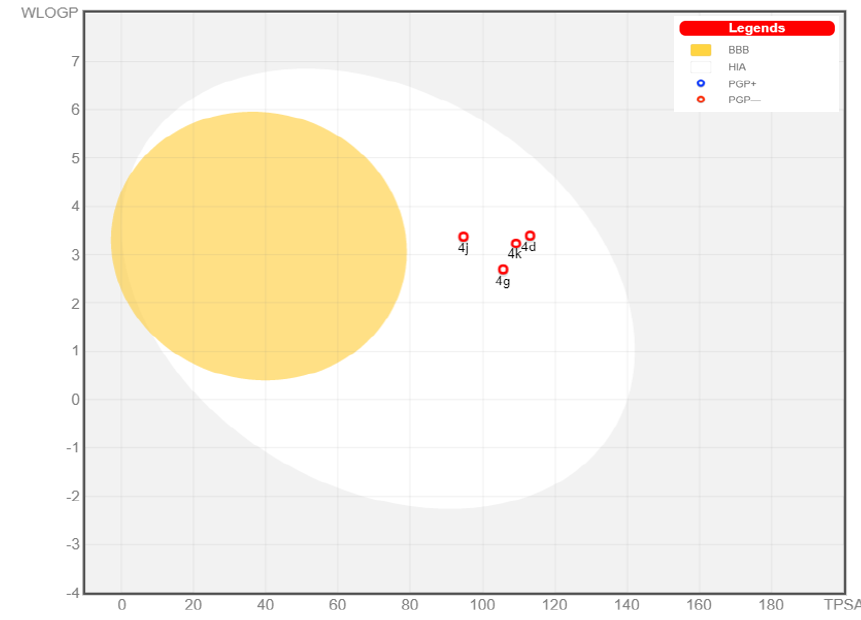
Figure 21. The BOILED-EGG chart for the studied compounds.